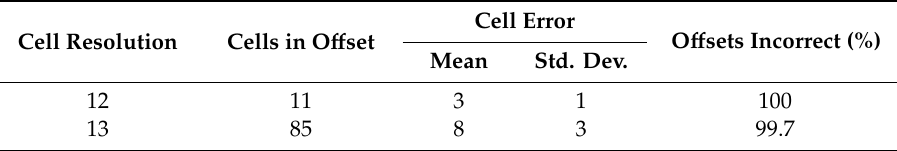
Table 2. Error statistics for modelling a mobile 30 m o ff set region at coarse resolutions when cells in C k are centred on c k